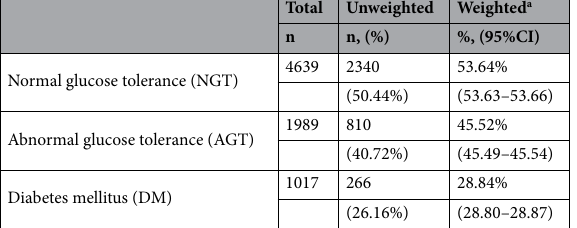
Table 2. The impact of glucose tolerance on seropositivity rates (%, with 95% confidence intervals [CI]) after hepatitis B vaccination. a P < 0.0001 for weighted percent among three states of glucose tolerance.